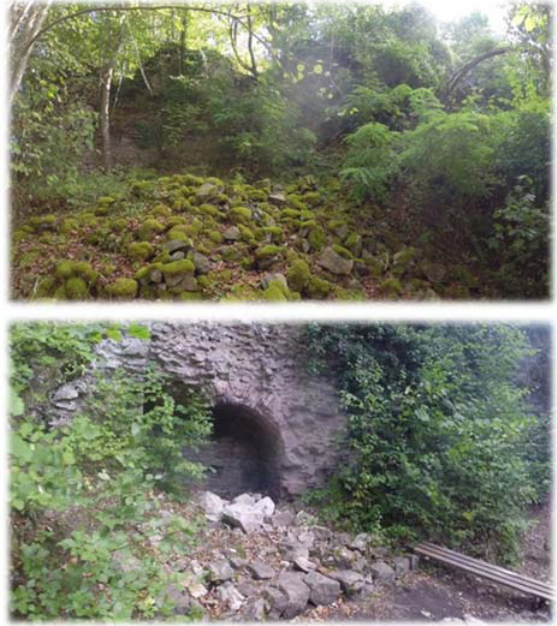
Figure 2: Dense vegetation